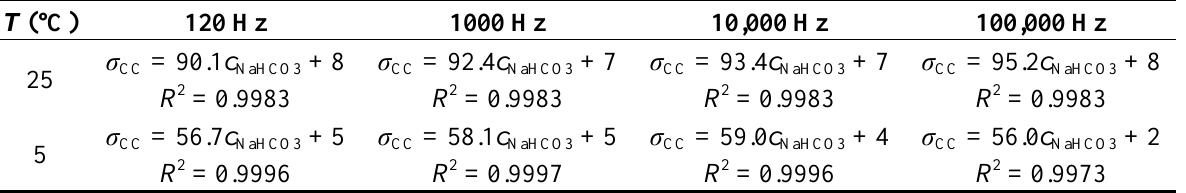
solutions (in duplicate) at 25 °C and 1000 Hz; 3